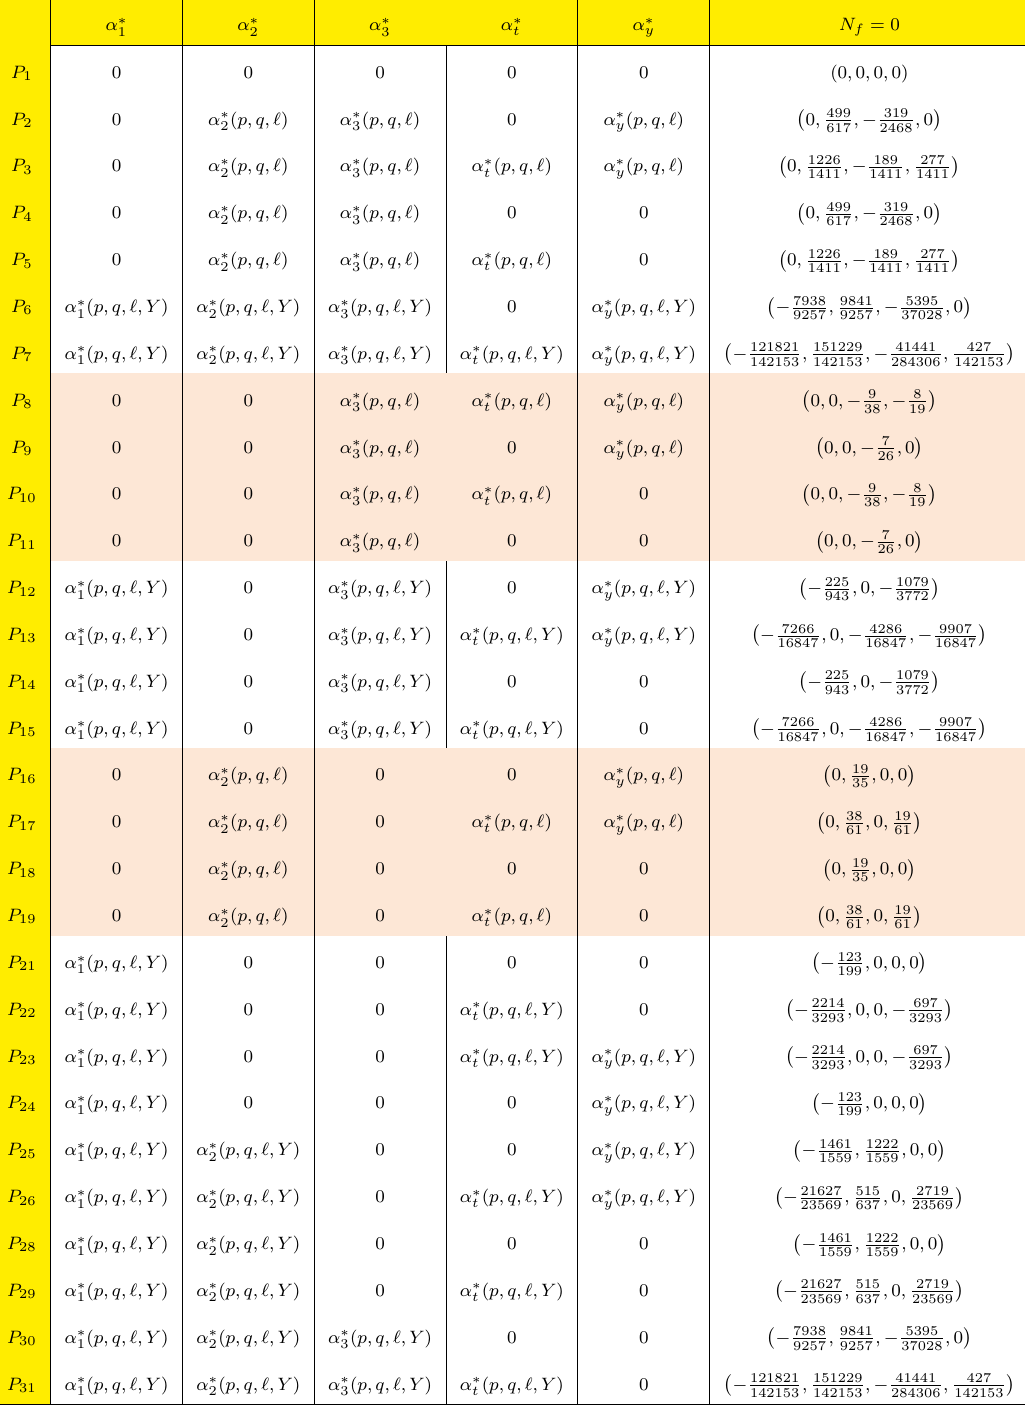
Table 12 . List of all the (cid:12)xed points in the 210 approximation scheme. When non-zero, the dependence on the quantum numbers is indicated. Only the highlighted (cid:12)xed points appear in the tables in the main text. The column N f = 0 contains the values for the